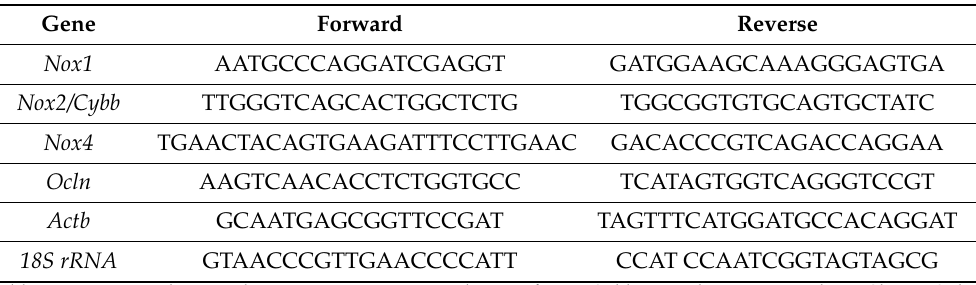
Table 1. Primer sequences (5 (cid:48) → 3 (cid:48) ) used for real-time PCR amplifications.